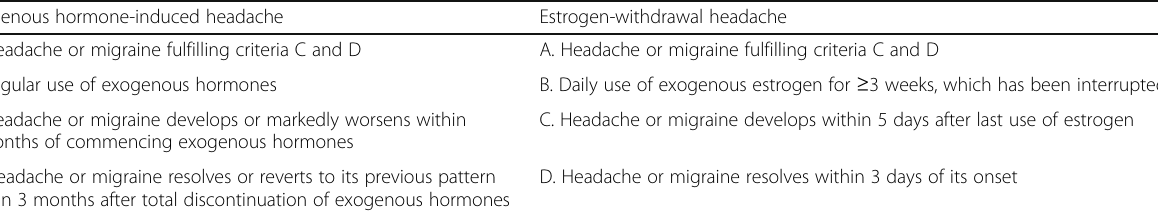
Table 2 IHS classification (ICHD-3) for exogenous hormone-induced headache and estrogen-withdrawal headache Exogenous hormone-induced